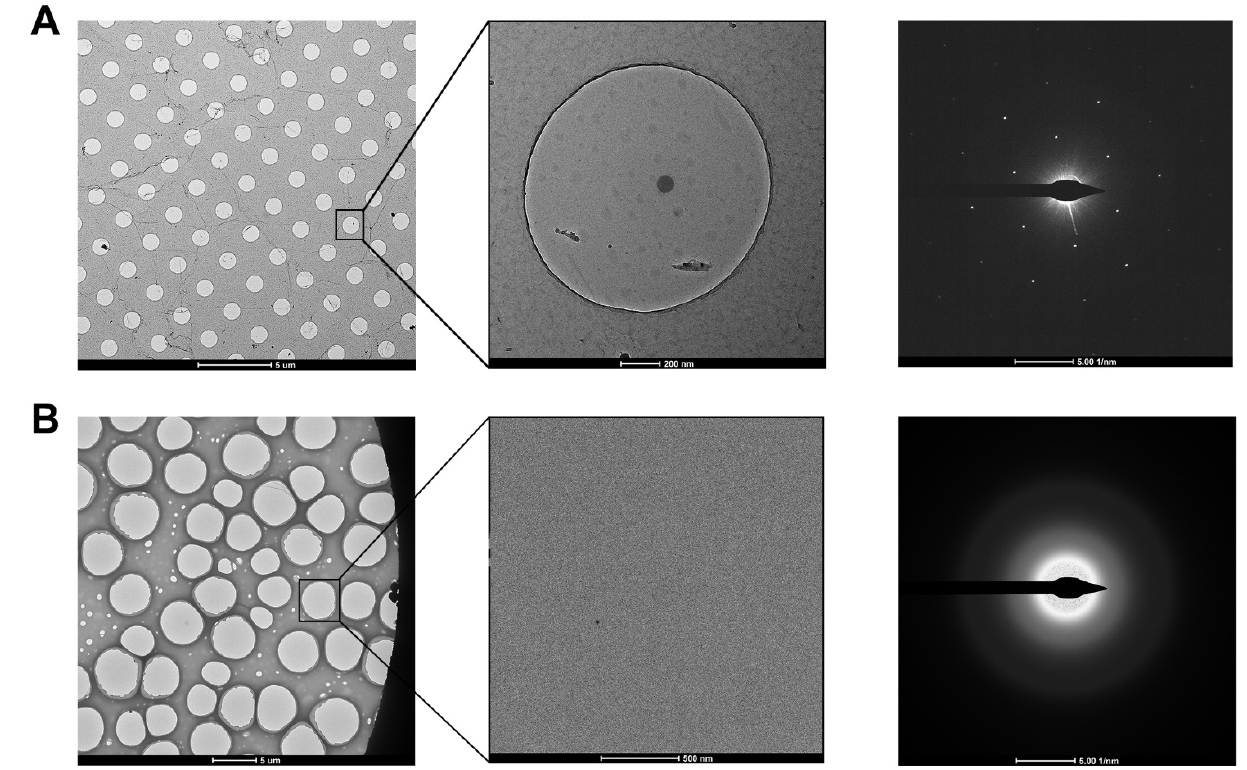
Figure 3. Examination of graphene and GO grids in the diffraction mode. ( A ) Graphene grid prepared using Quantifoil grid. The diffraction pattern showed the single-layer coverage in the zoomed-in hole. ( B ) GO grid prepared using holey carbon grid (purchased from Beijing Zhongjingkeyi Technology Co., Ltd. Beijing, China). The diffraction pattern showed the multi-layer coverage in the zoomed-in hole.